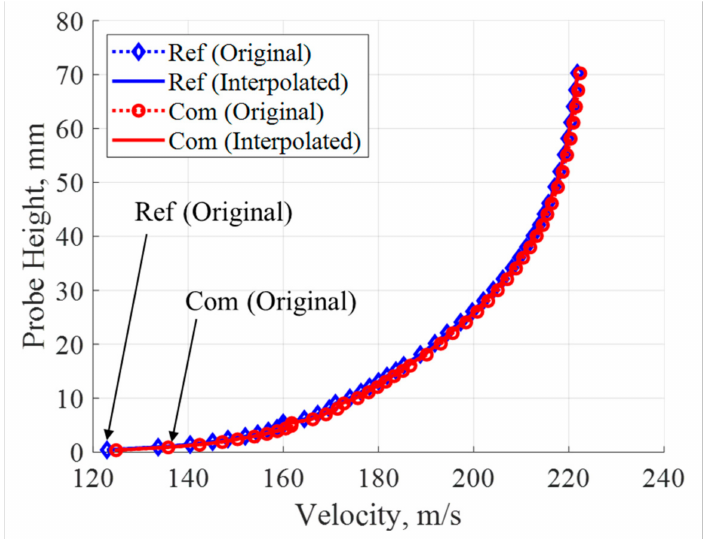
Figure 6. Example case ( M ∞ = 0.73, α = 0.78 ◦ , P ∞ = 42.0 kPa, T ∞ = 221.6 K) of the original velocity profiles superimposed with the interpolated